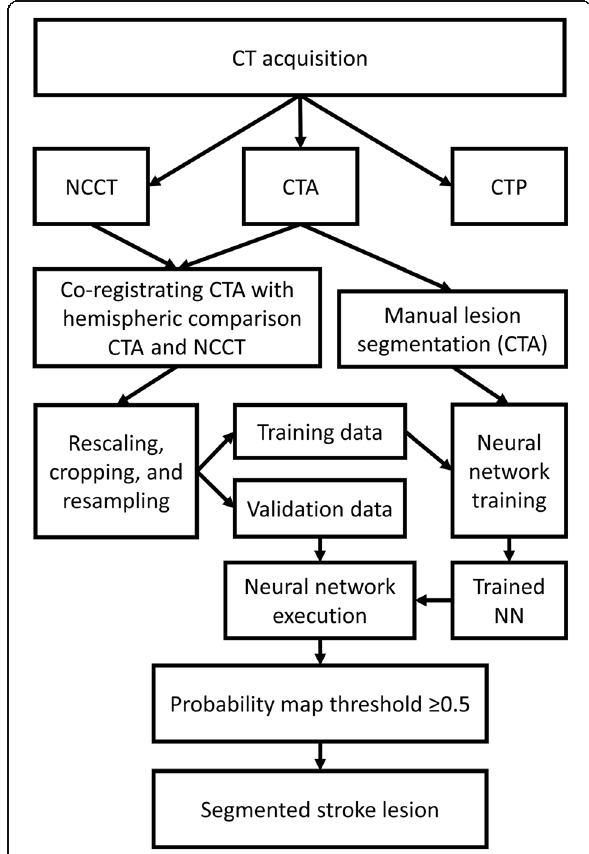
Fig. 1 The data processing workflow. CT, computed tomography; NCCT, non-contrast CT; CTA, CT angiography; CTP, CT perfusion; NN, neural